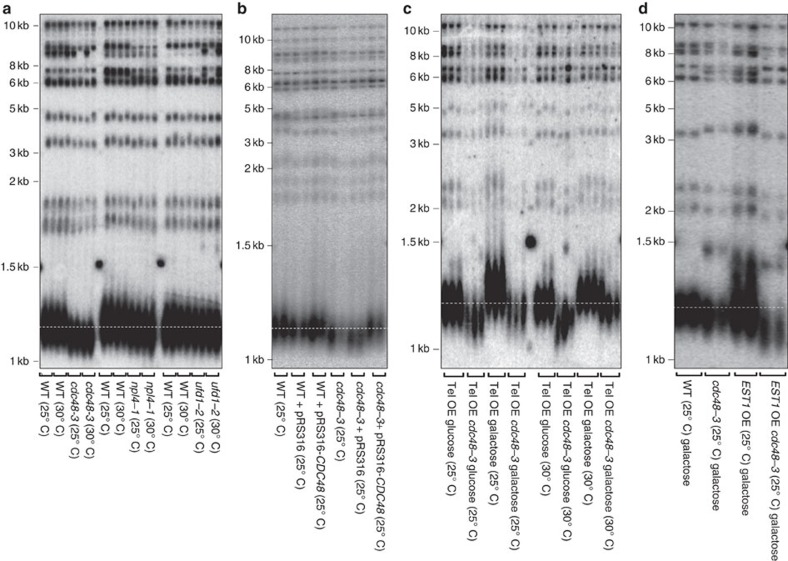
Telomeres are shorter in cdc48-3 and npl4-1 cells than in WT cells.(a) Southern analysis of DNA from two independent colonies of cdc48-3, npl4-1, and ufd1-2 cells and their respective (WT) isogenic controls was digested with XhoI and analysed by Southern blotting. Temperatures at which cells were grown are indicated. (b) Telomere length of WT or cdc48-3 cells carrying a centromere plasmid with (pRS316-CDC48) or without the CDC48 gene (pRS316) was determined as in a. Symbols are as in a. (c) Southern analysis showed cdc48-3 cells have shorter telomere length in telomerase OE cells, as compared with their WT counterpart, at both permissive and semi-permissive temperatures. Each lane is an independent isolate. (d) Southern analysis of telomere length in Est1 OE cdc48-3 and WT cells.